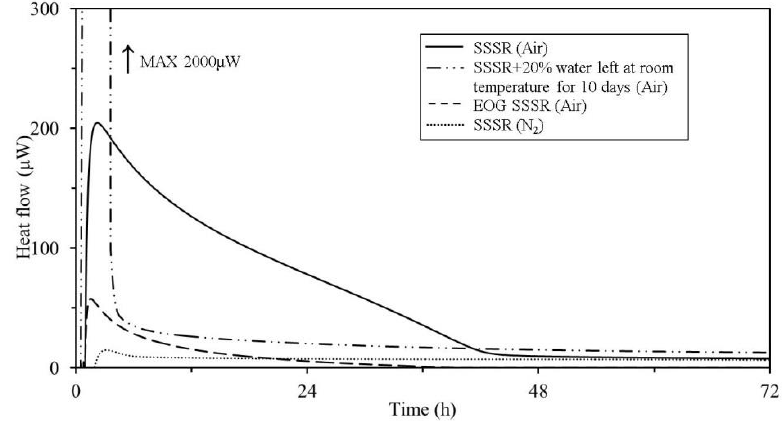
Figure 10. TAM-calorimetry results for SSSR.